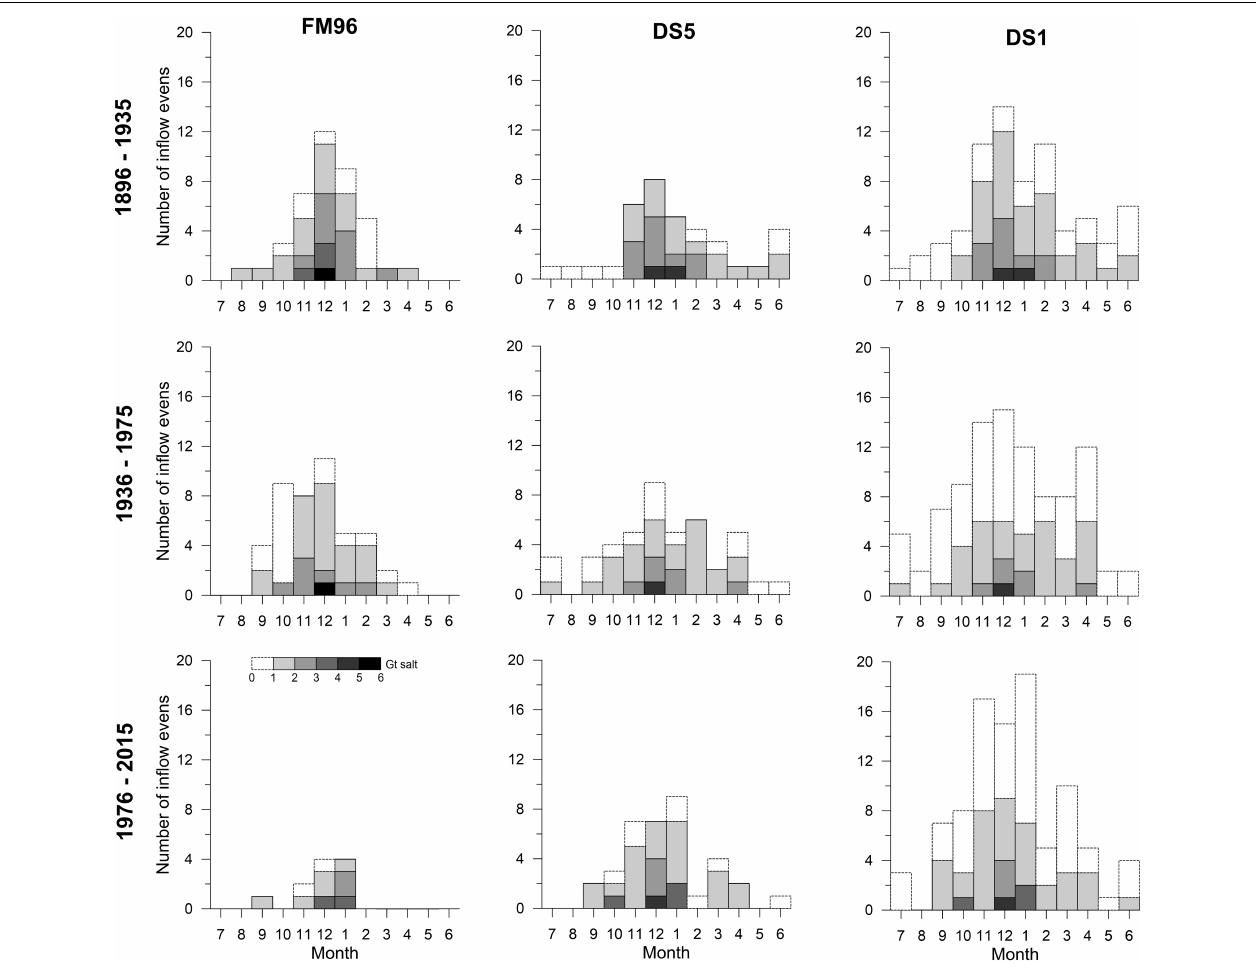
FIGURE 6 | Monthly frequency of inflow classes during the three subsequent 40-year periods of 1896–1935 (top) , 1936–1975 (middle), and 1976–2015 (bottom) for the inflow series FM96, DS5, and DS1. TABLE 2 | Number of barotropic inflow events of inflow series FM96, DS5, and DS1 for three 40 year periods and different size classes.